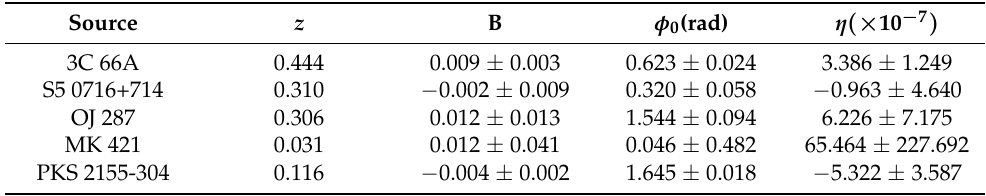
Table 2. Best-fitting results of multiwavelength polarization observations for five blazars. Source